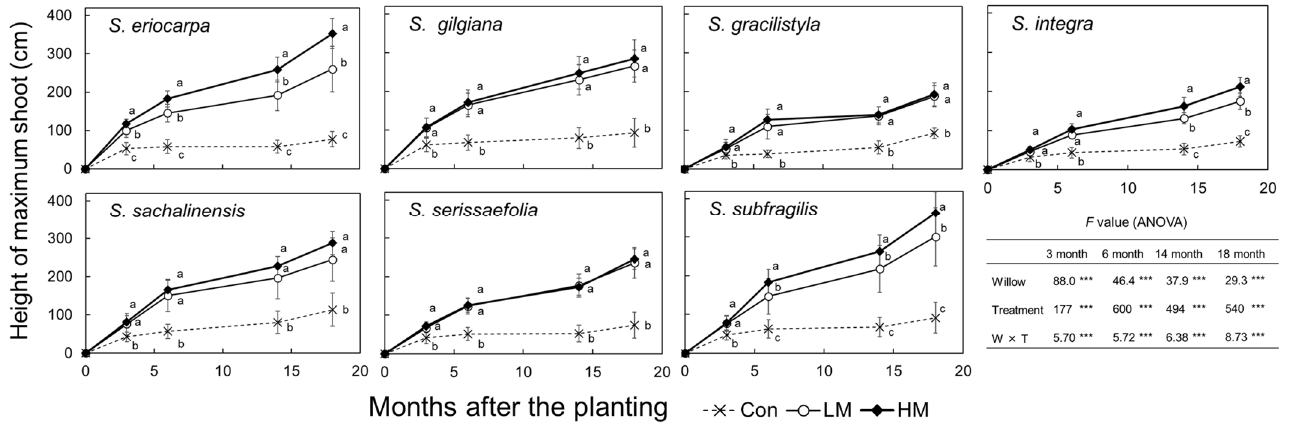
Figure 4. Height of largest shoot of individuals of seven willows grown under three treatments (mean ± SD). The number of individuals were as shown in Table 3. Asterisks indicate significant differences among seven willows, three treatments, and their interaction (W × T) calculated by ANOVA (*** = p < 0.001). Different alphabetical letters indicate significant differences between three treatments based on Tukey test ( p < 0.05).